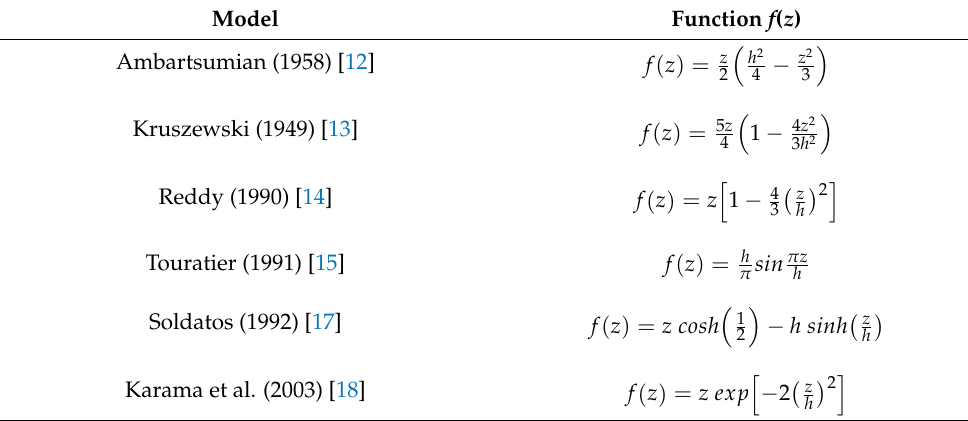
Table 1. Function f ( z ) for different high order shear stress distribution.